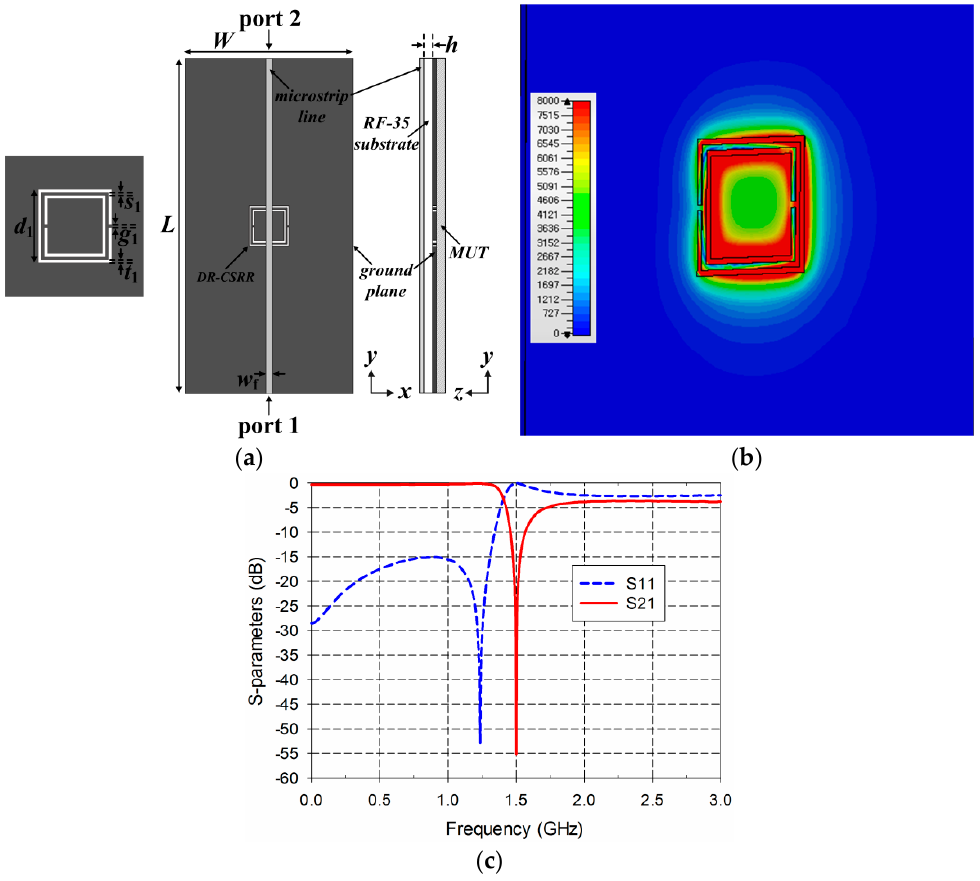
Figure 2. DR-CSRR-based permittivity sensor: ( a ) structure; ( b ) electric-field distribution at 1.5 GHz; ( c ) S-parameter characteristics.